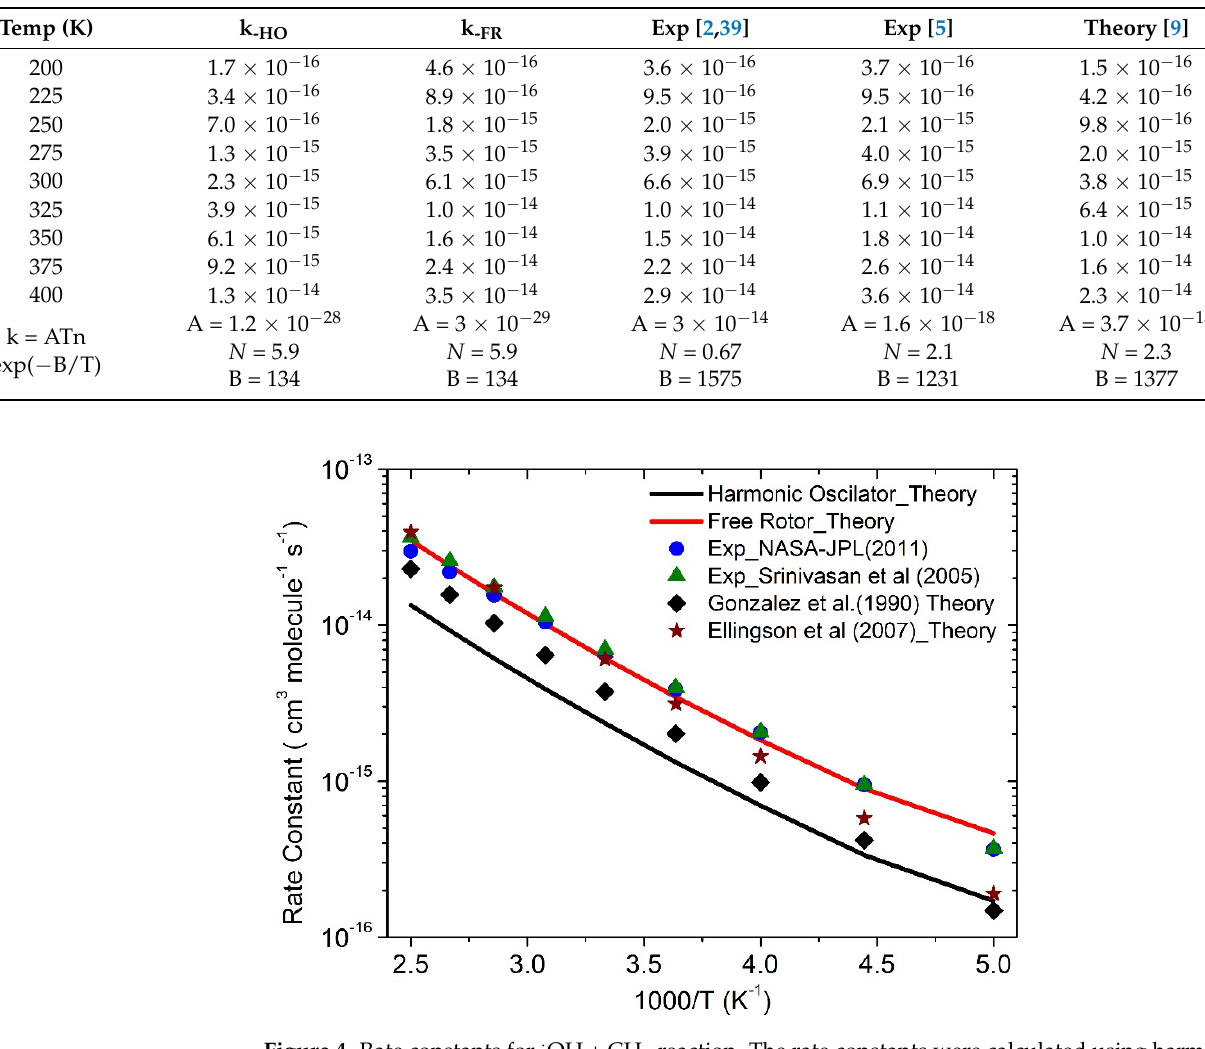
Figure 4. Rate constants for · OH + CH 4 reaction. The rate constants were calculated using harmonic oscillator and free-rotor approximation.